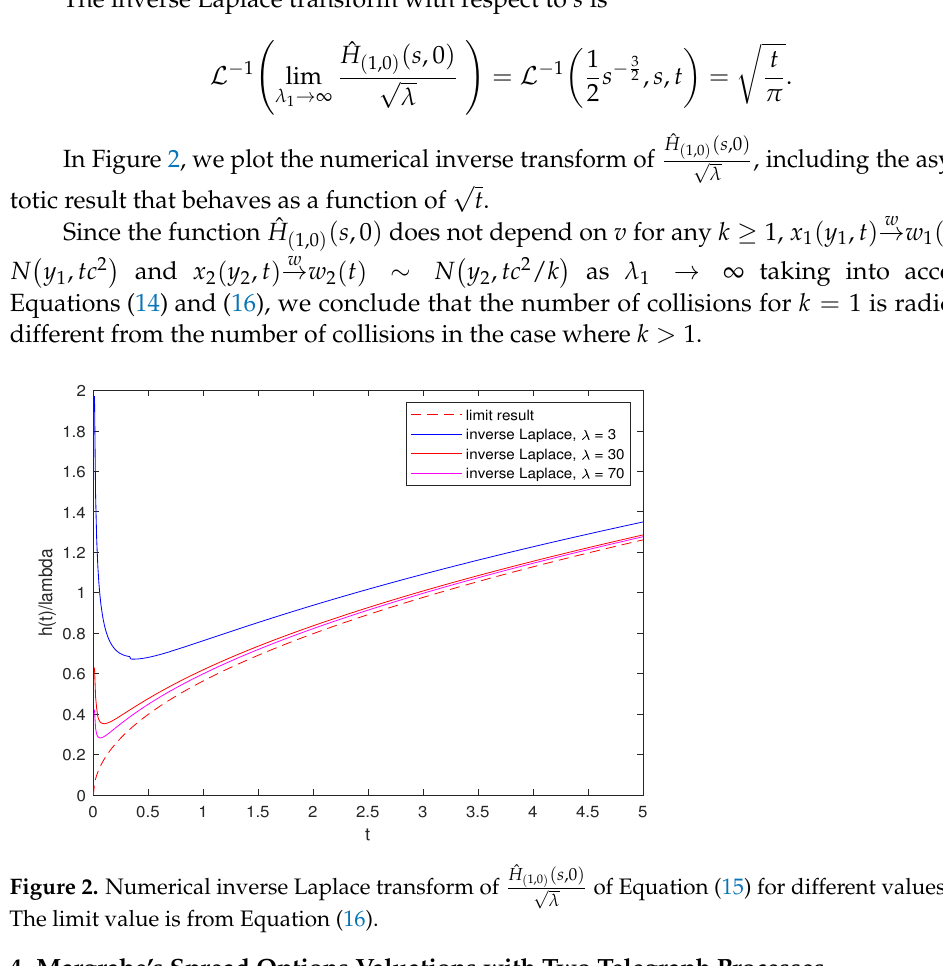
Figure 2. Numerical inverse Laplace transform of The limit value is from Equation